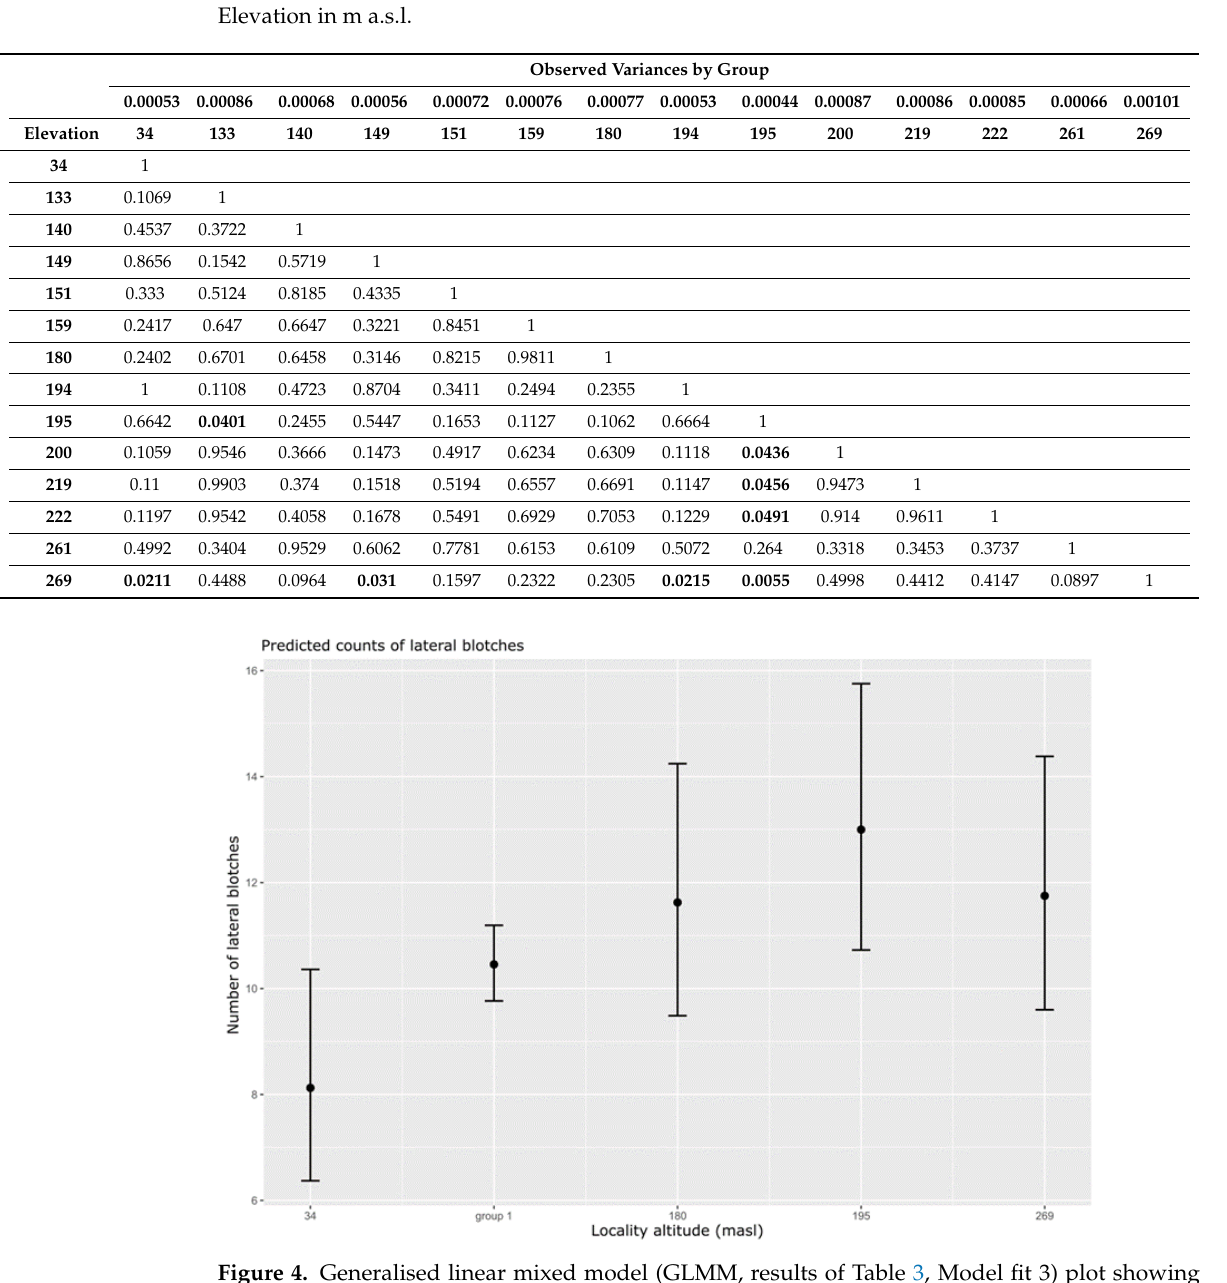
Figure 4. Generalised linear mixed model (GLMM, results of Table 3., Model fit 3) plot showing a significant correlation between the number of lateral spots and elevation (numbers represent locality altitude in meters) (results of Table 3., model 3.) for 111 individuals of Sabanejewia spp. Elevation: 34 m–River Danube (type locality Vidin, Vrav, BG); 180 m and 195 m–River Petrinjˇcica (loc. Mioˇcinovi´ci, Dodoši, HR); 269 m–River Treska (type locality Skopje, NMK), group1–other localities (133–261 m elevation) (Table